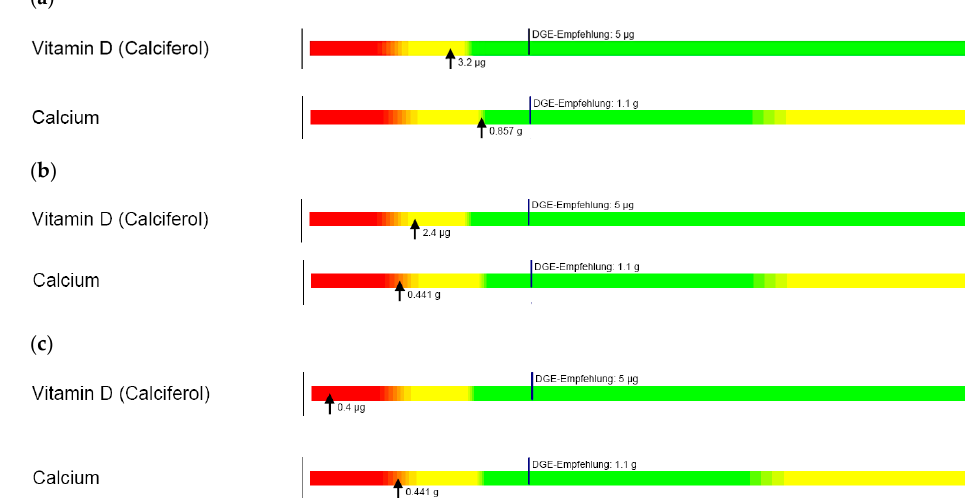
Figure 4. Typical dietary vitamin D and calcium intakes in ( a ) African; ( b ) Middle-Eastern and ( c ) Asian families. (Arrows indicate the actual intake, while vertical lines represent the recommended daily intake). DGE empfehlung = German Nutrition Society (DGE) recommendation